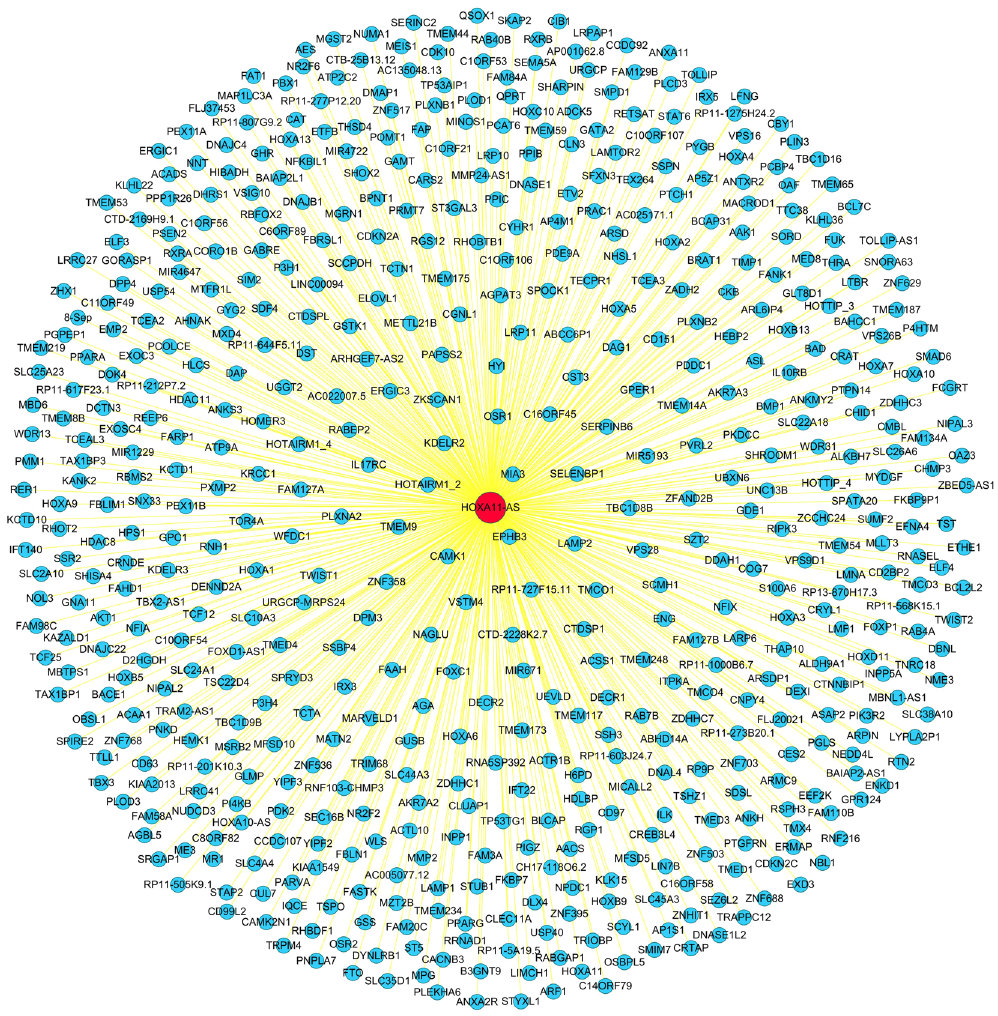
Figure 13. The network of 574 co-expressed genes of HOXA11-AS overlapping in two probe sets (230666_AT and